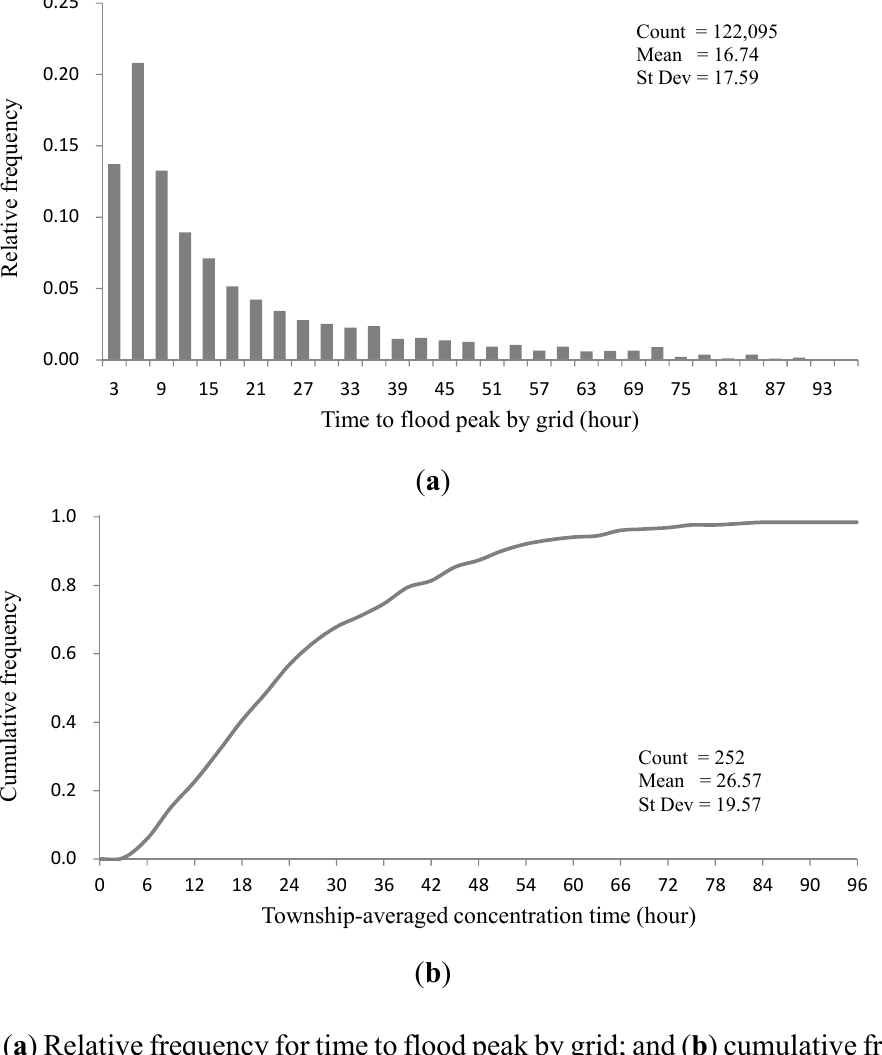
Figure 2. ( a ) Relative frequency for time to flood peak by grid; and ( b ) cumulative frequency for township-averaged centration